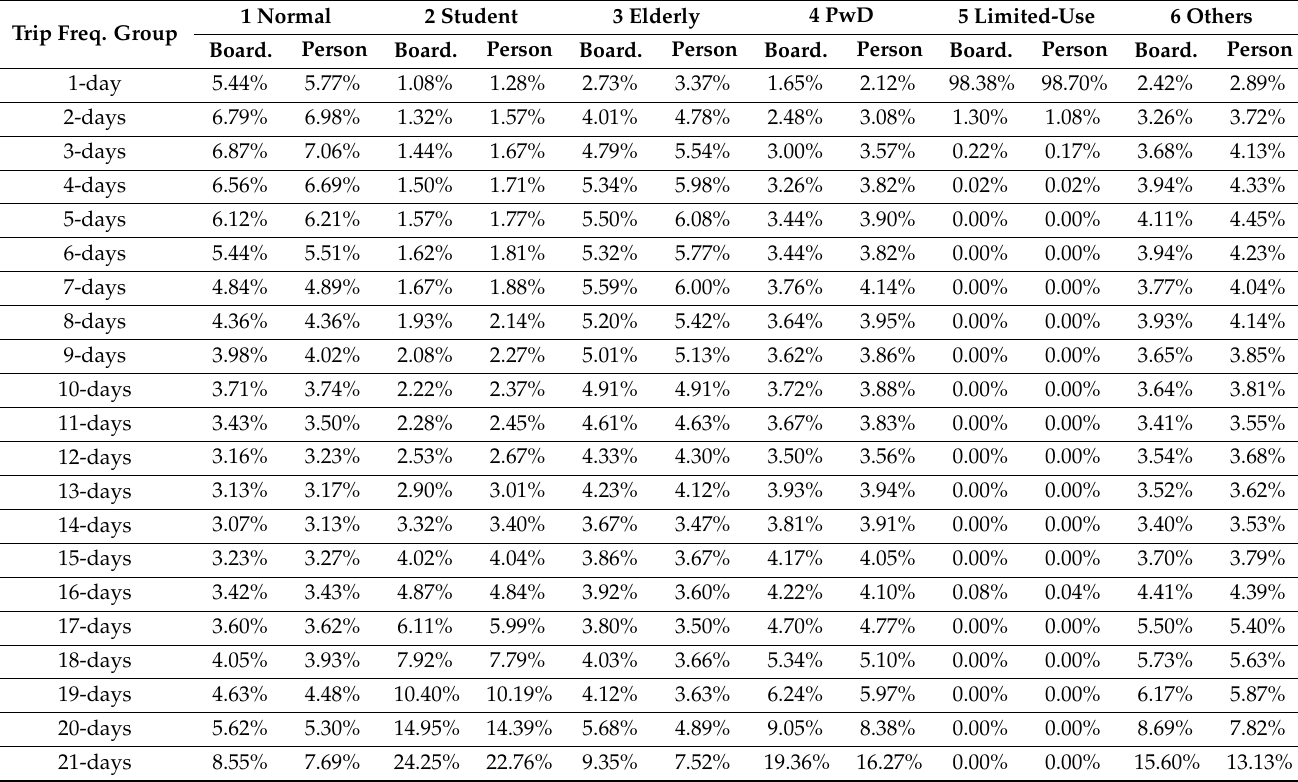
Table A3. Workday trip-frequency distribution among the categorized user groups.